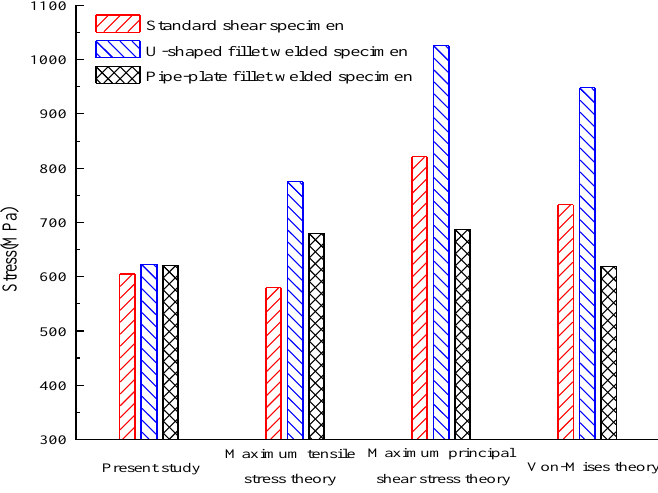
Figure 14. FEM and nodal force distribution of the tube-plane fillet welded specimen.